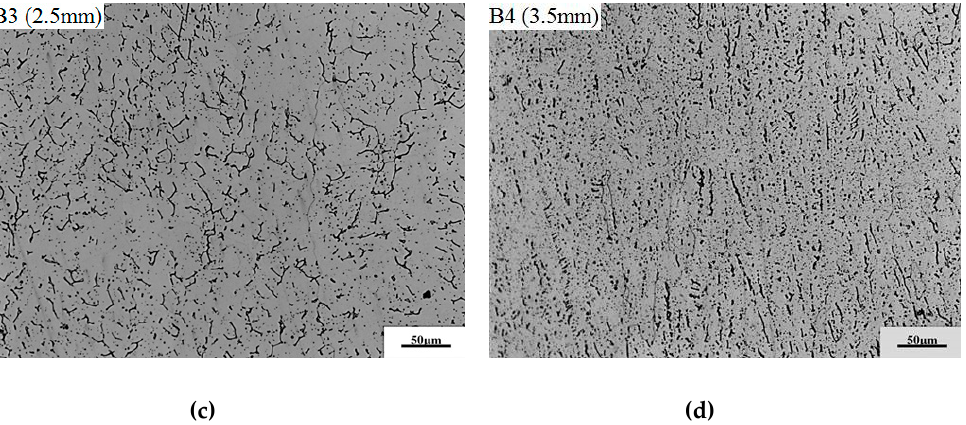
Figure 7. Effect of repair weld reinforcement height on the microstructure in the weld center: ( a ) 0.5 mm, ( b ) 1.0 mm, ( c ) 2.5 mm and ( d ) 3.5 mm.